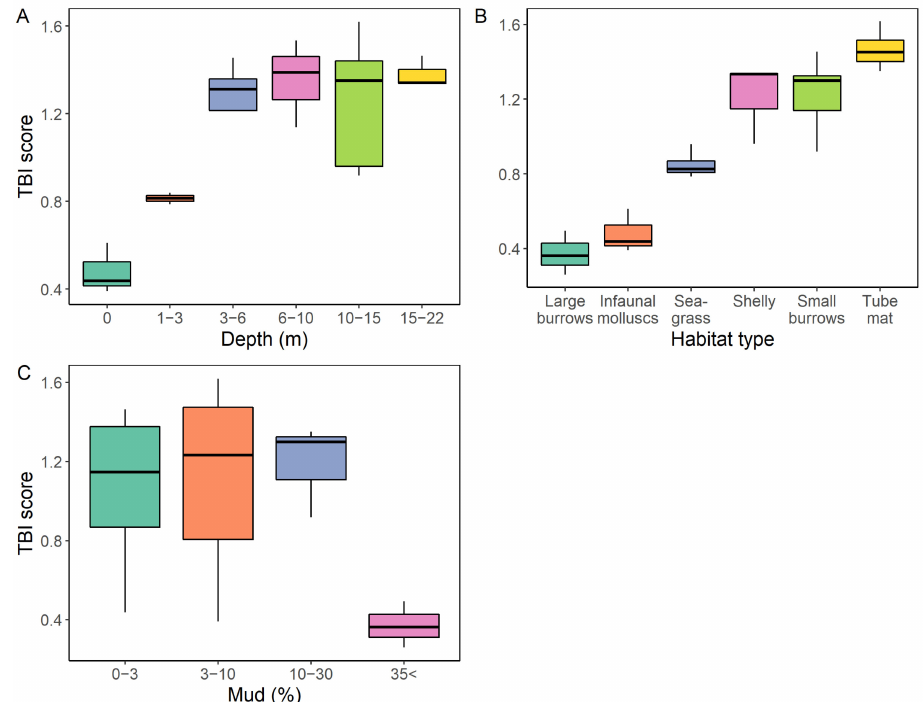
Figure 7. TBI scores as a function of ( A ) water column depth, ( B ) habitat type, and ( C ) sediment mud content.